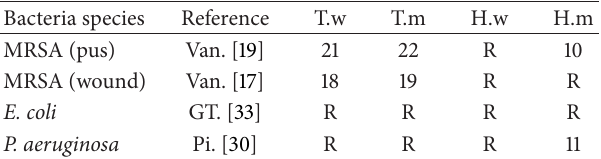
Table 1: Antibacterial activity of water and methanolic extracts of Camellia sinensis and Hibiscus sabdariffa on tested Gram positive and Gram negative bacteria.